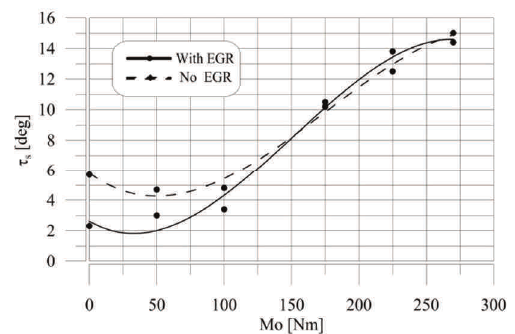
Fig. 8. Influence of the engine load on the NO x concentration in exhaust gases for engine operating with/without EGR